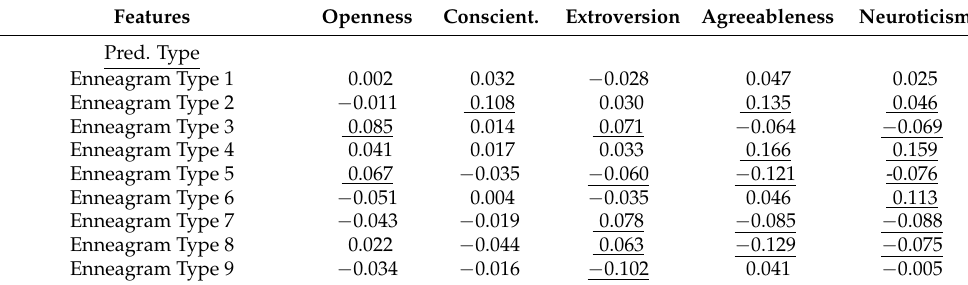
Table 15. The Pearson correlation coefficient of the gold-standard Big Five labels with the predicted values of Enneagram types as reported by Gjurkovi´c et al. [7] CC-BY-NC. Features Openness Conscient.